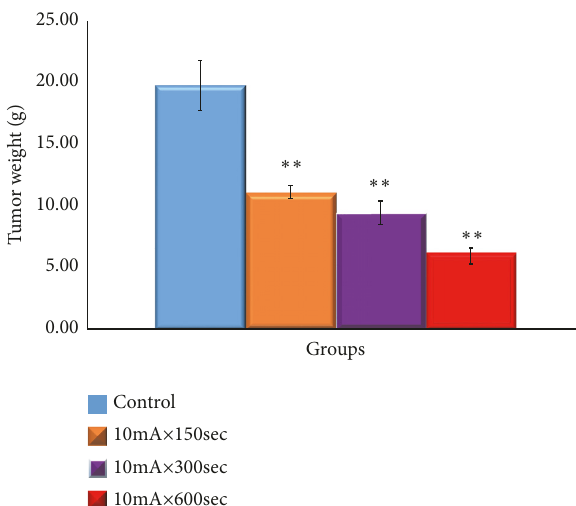
Figure 4: Tumor growth-inhibitory effect of ECT in Sarcoma-180 cells-bearing mice. Changes in the weight of the tumor. After tumor implantation, we measured the weight of the fifth week of the tumor of each group. The results represent ± S.D from 8 to 10 mice. ∗∗ Significantly different from the control group ( p < 0.01 ).